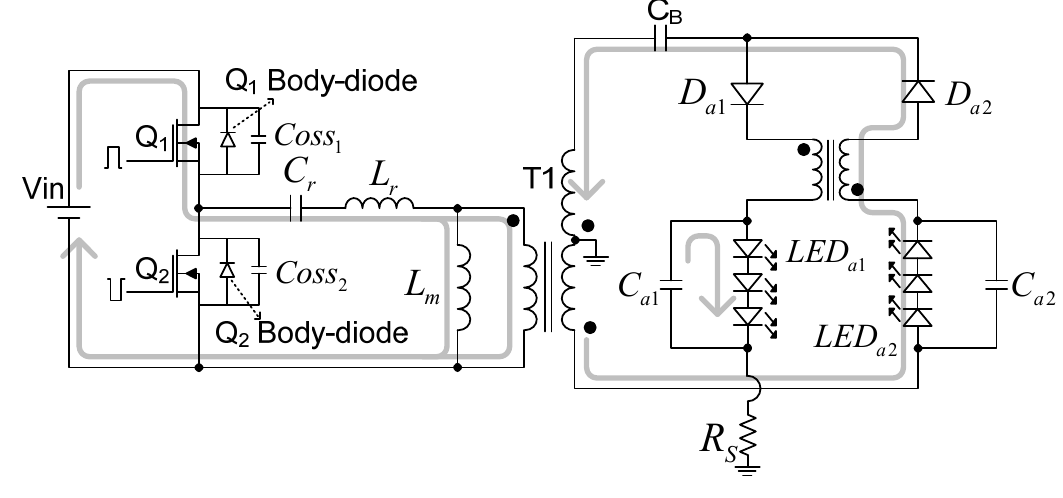
Figure 7. Circuit diagram during Mode 2.